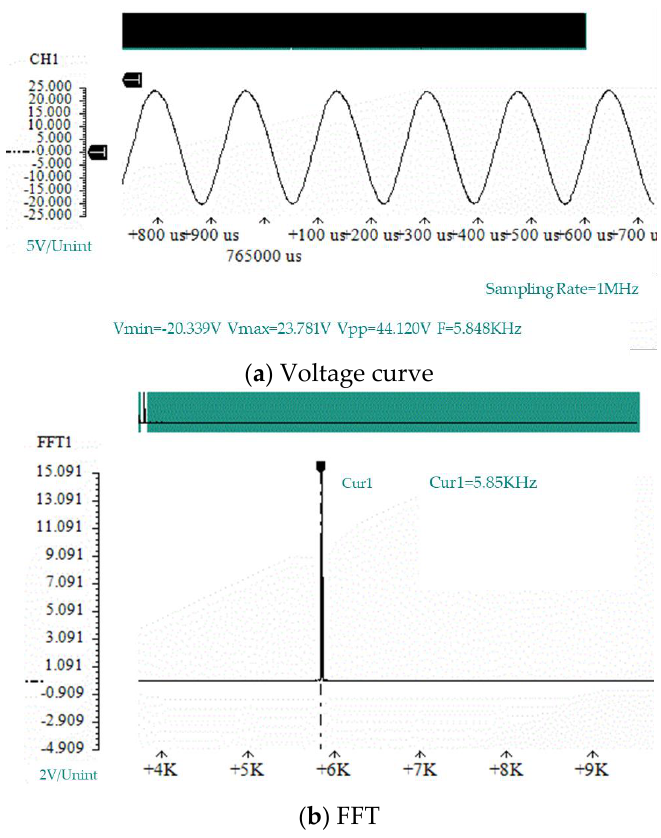
Figure 9. The open-circuit voltage of piezoelectric vibrator no. 1 of prototype #2 at V = 100.8 m/s.